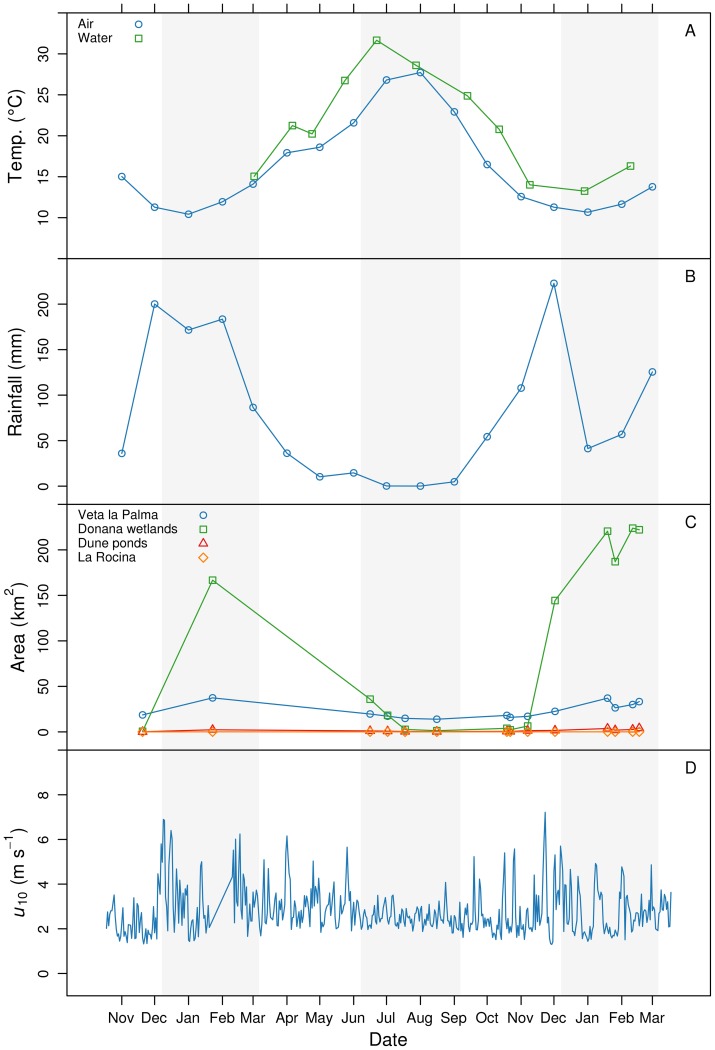
Time-series plots of air and water temperature (A), atmospheric  (B), monthly rainfall (C) and daily mean wind velocity at a height of 10m,  (D).Light and dark shading represents seasons.